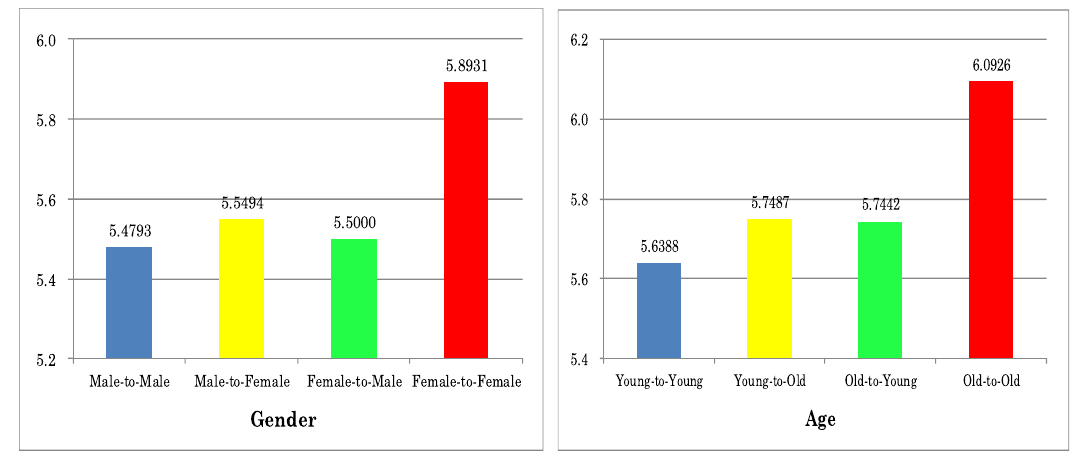
Fig. 5 Referrer-investor relationships and investor hierarchy. The left-hand graph illustrates how the gender-to-gender referrer-investor relationship affects layers in the investor hierarchy and the right-hand graph illustrates how the age-to-age referrer-investor relationship affects layers in the investor hierarchy. They are based on OLS results.